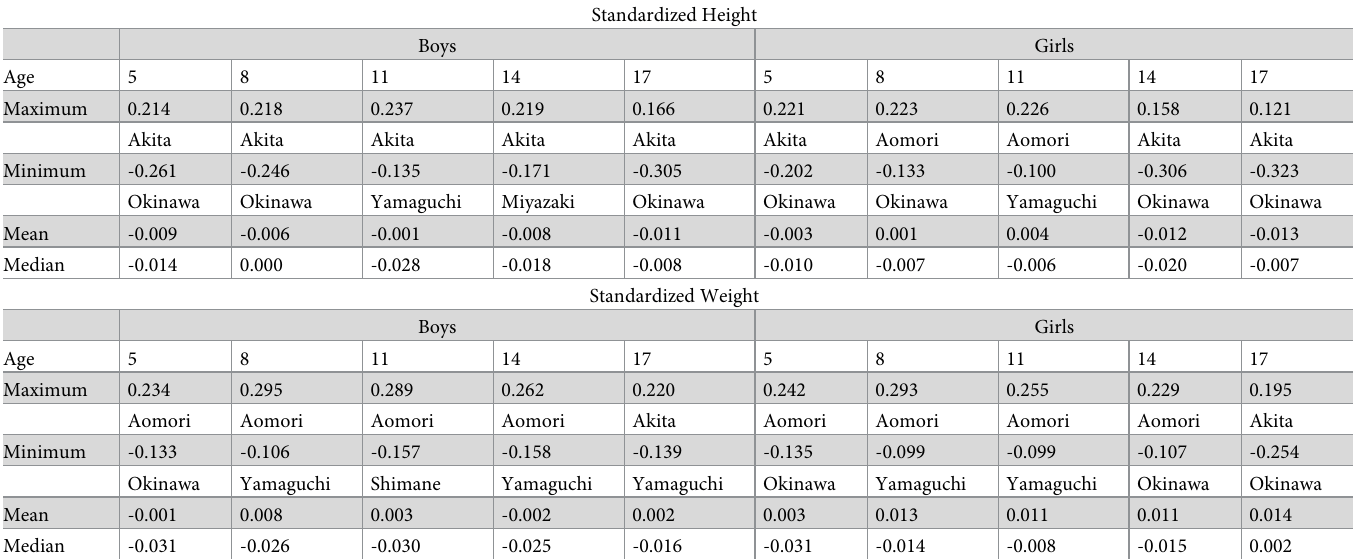
Table 1. Basic statistics for standardized heights and